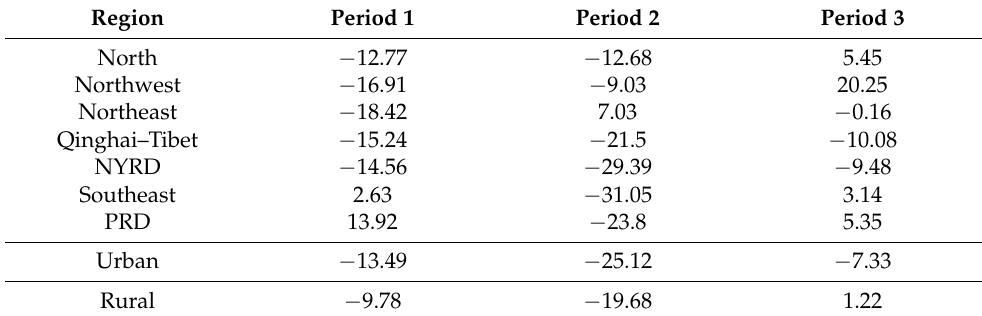
Figure 5. ( a ) Estimated PM 2.5 change rates between the reference semester model and pandemic semester model predictions in sub-period 1; ( b ) Estimated PM 2.5 change rates between the reference semester model and pandemic semester model predictions in sub-period 2; ( c ) Estimated PM 2.5 change rates between the reference semester model and pandemic semester model predictions in sub-period 3. Beijing–Tianjin–Hebei Region, Yangtze River Delta and Sichuan Basin are marked in red, black and purple, respectively. Table 2. Estimated PM 2.5 change rates by region and by land type during modeling periods